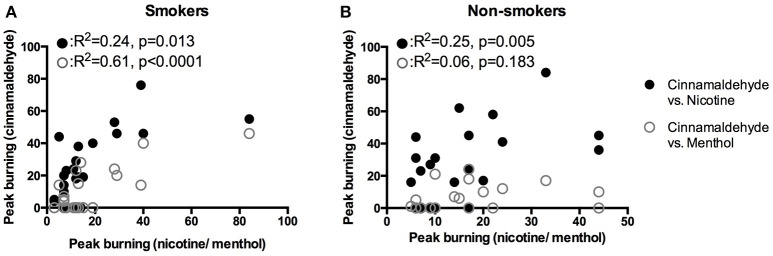
Correlations of peak burning intensity in response to the nicotine, menthol, and cinnamaldehyde for smokers (A) and non-smokers (B).